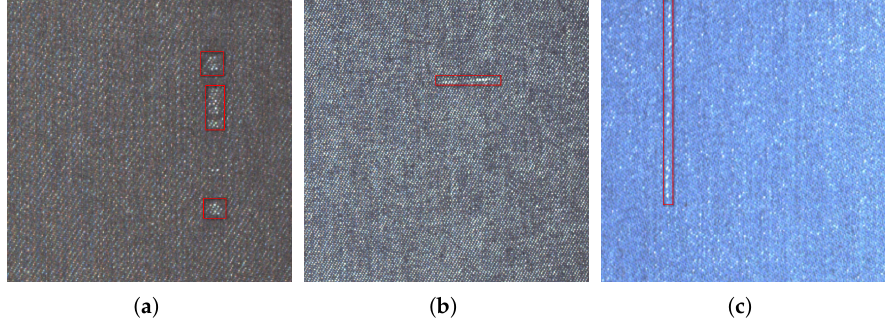
Figure 1. Three kinds of defects on the fabric surface. ( a ) Regional defects in fabrics; ( b ) Weft defect in fabric; ( c ) Warp defect in